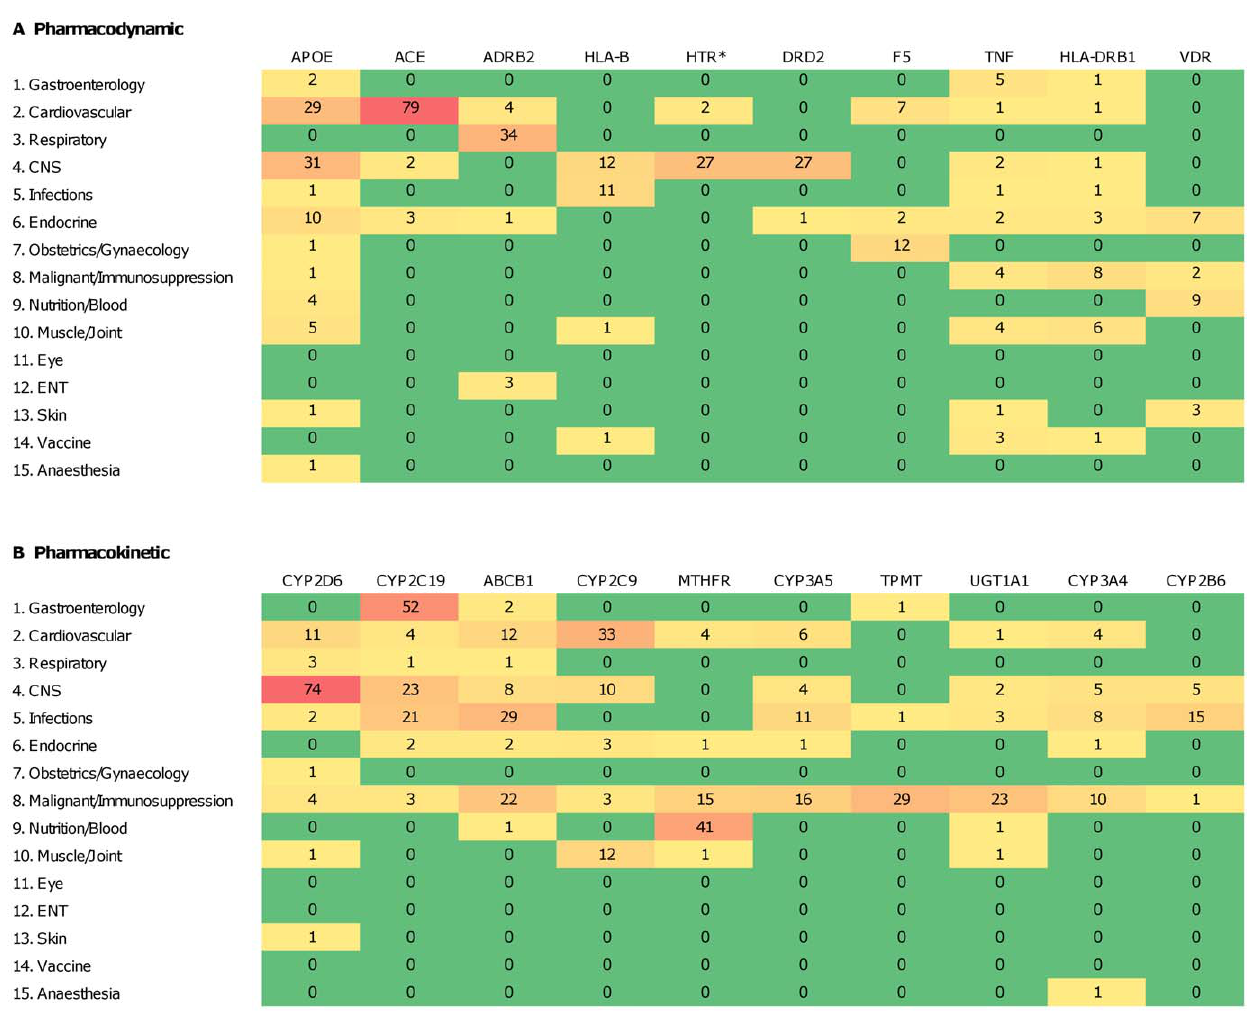
Figure 4. Categories of drugs evaluated in pharmacogenetic studies of the 10 most frequently studied genes. (a) pharmacodynamic; and (b) pharmacokinetic. Numbers represent total studies per gene and drug category, with cell color shading to emphasize value (heat matrix). CNS=central nervous system; ENT=ears, nose and throat. Drugs are classified as in British National Formulary (http://www.bnf.org).